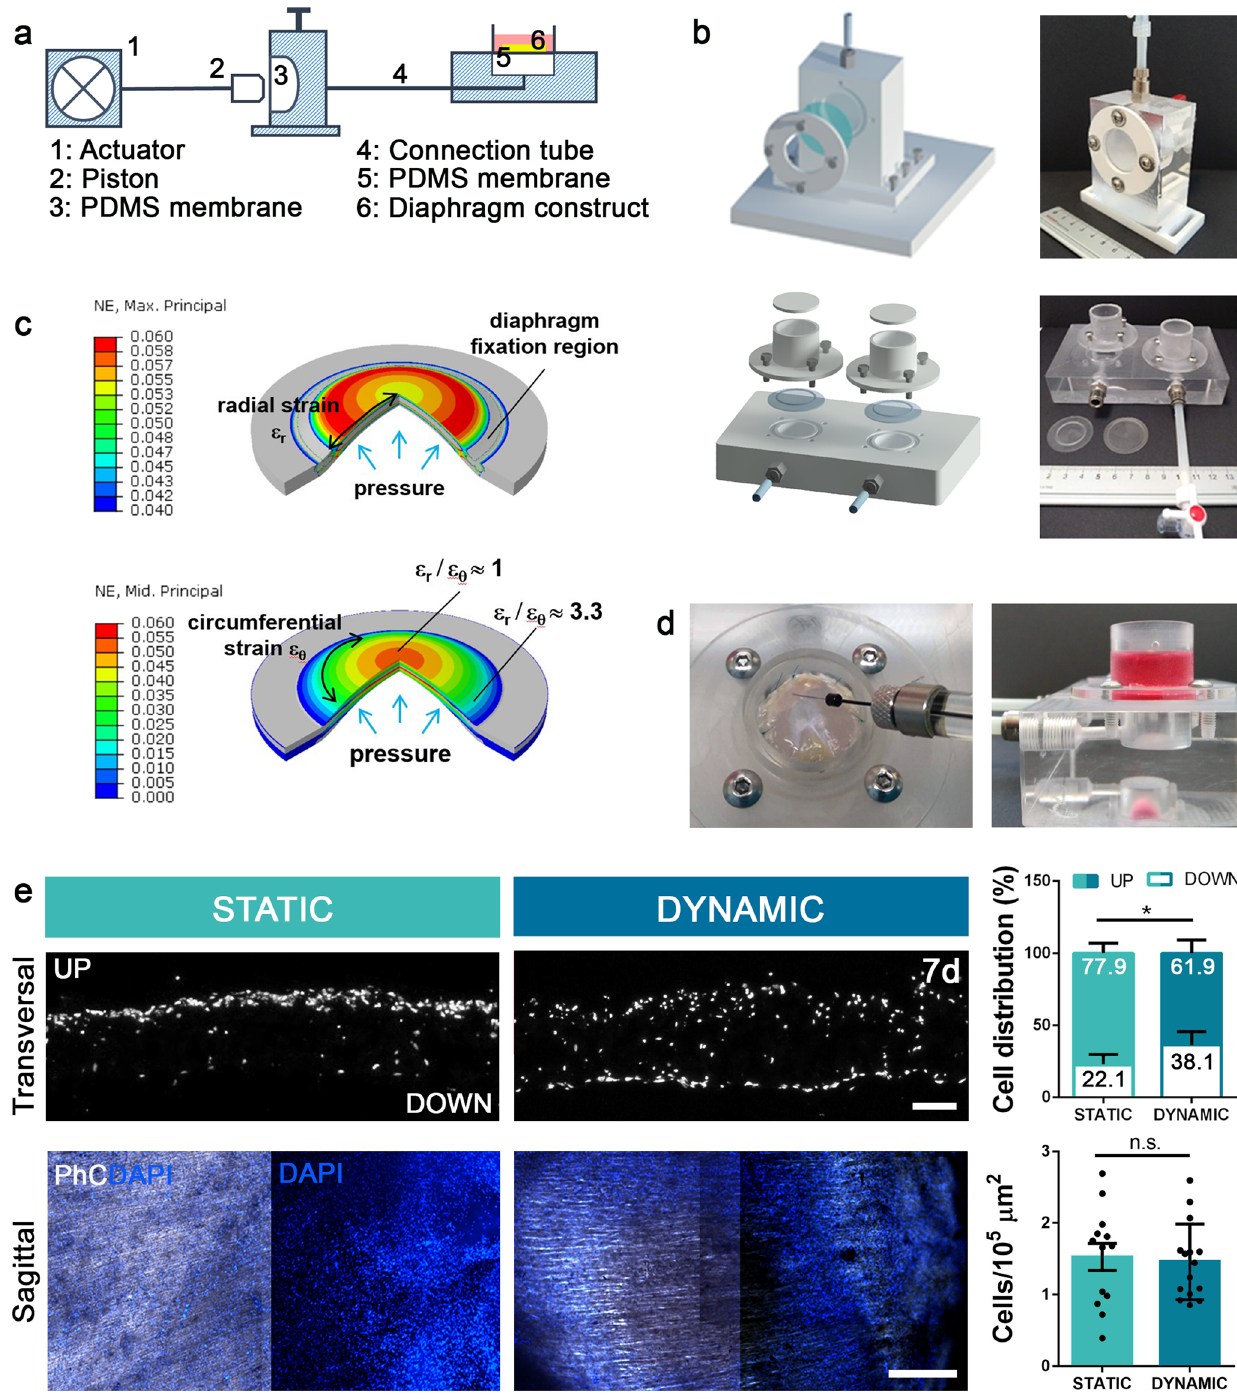
Fig. 2 Bioreactor design, manufacture, and validation. a Simpli fi ed schematic of the bioreactor used: components 1 – 3 are part of the “ motor bench unit ” while components 4 – 6 are part of the “ incubator bench unit ” . b 3D-designed and manufactured bioreactor components. c FEM analysis was performed to evaluate the induced strain on PDMS membranes as a function of the hydrostatic pressure applied through the hydraulic circuit. Radial and circumferential strains are shown on a three-quarter section view. The diameter of the deformed membrane is 22 or 24 mm, according to the size of the stimulated diaphragmatic construct. d Representative images of cell injection and 3D culture. Scale bars: 1 cm. e Representative images of transversal and sagittal views of test 3D static and dynamic samples, with quanti fi cation of cell number (Cells/10 5 μ m 2 ) and cell distribution (percentage of cells detected in the upper or lower scaffold side) ( n = 3 per group; 10 random high- powered fi elds per sample; mean ± s.d.). PhC phase contrast, DAPI cell nuclei. Scale bars: 50 μ m and 1 mm. * p < 0.05; n.s. not-signi fi